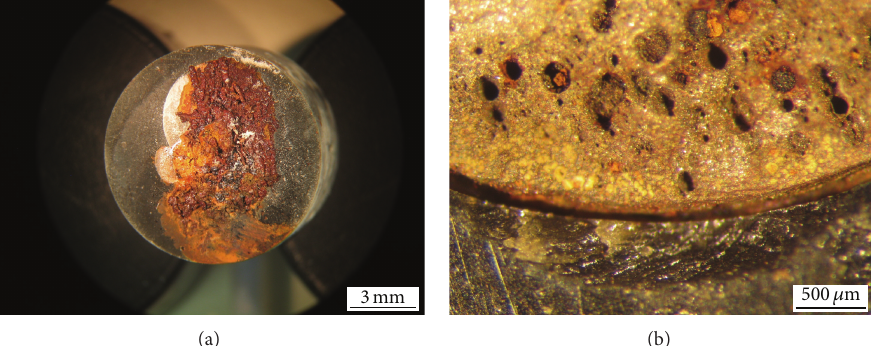
Figure 2: (a) Specimen extracted from the cell after pitting initiation during potentiostatic polarization test: (b) details of the surface showing